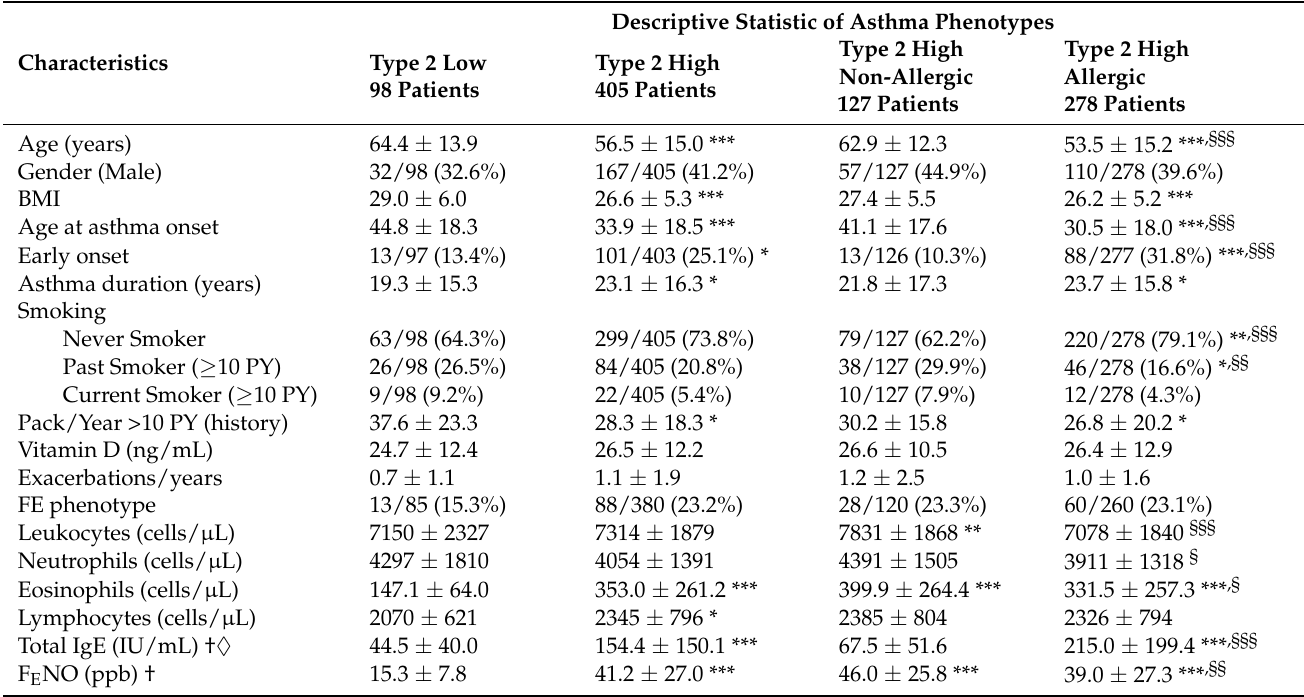
Table 3. Descriptive statistic of patients ( n = 503) stratified according to asthma phenotypes. The results are expressed as mean with standard deviation or as the number of subjects with